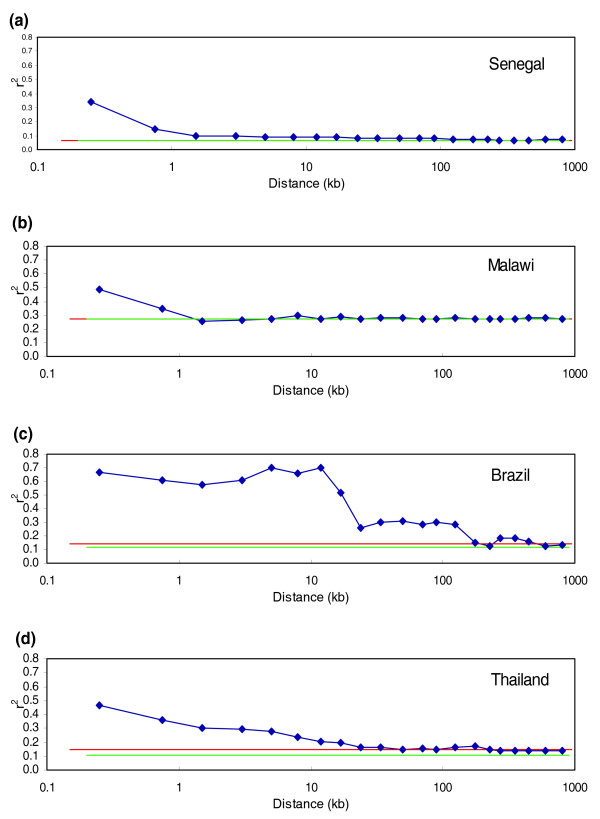
Linkage disequilibrium, measured by r2, for each of the four population samples: (a) Senegal; (b) Malawi; (c) Brazil; (d) Thailand. Plotted are the measured r2 for linked markers (blue lines) and for unlinked markers (red lines), as well as the level of background LD expected because of small sample size (green lines).